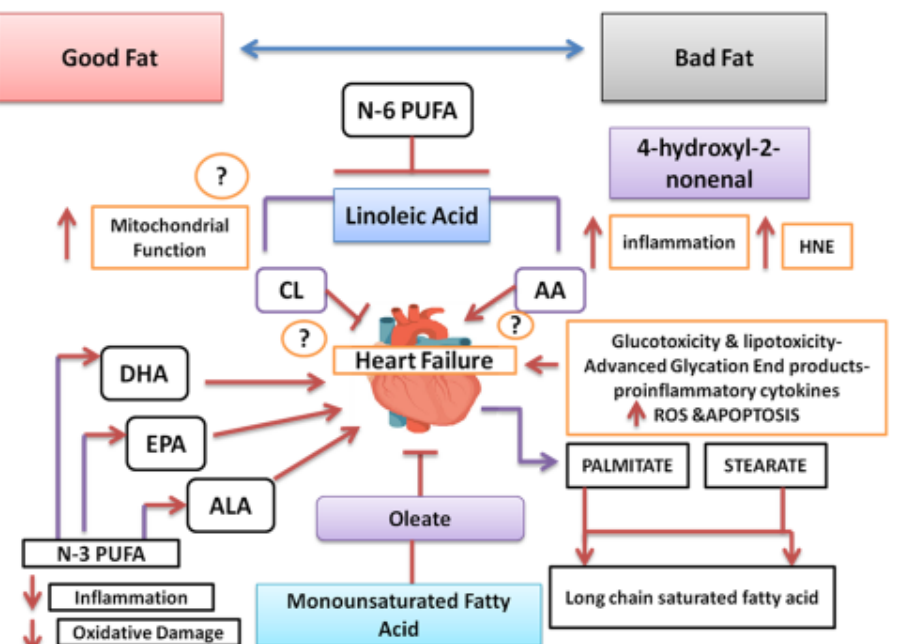
Figure 4. Depiction of mechanisms of how a high-saturated-fat and high-glucose diet is necessary for causing progression of heart failure, and good fat with flavonoids causes improvement. (Modified from Stanley et al., Circ Res, 2012, Reference [48], American Heart Association.) TMAO = Tri-methylamino-N-Oxide.